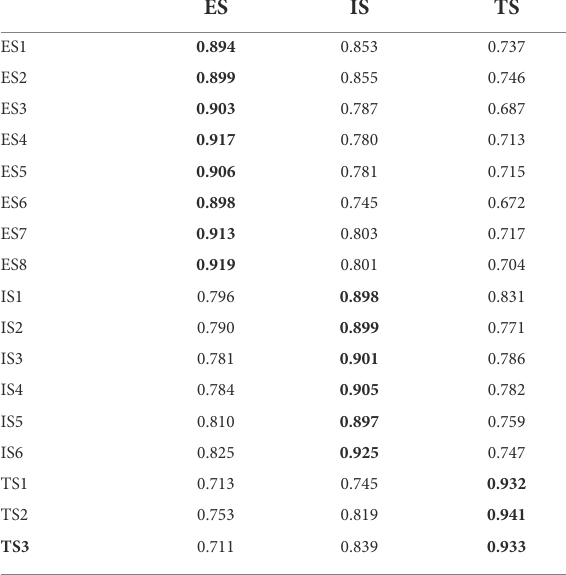
TABLE 6 The cross-loadings of construct. TABLE 5 The cross-loadings of first-order construct (social